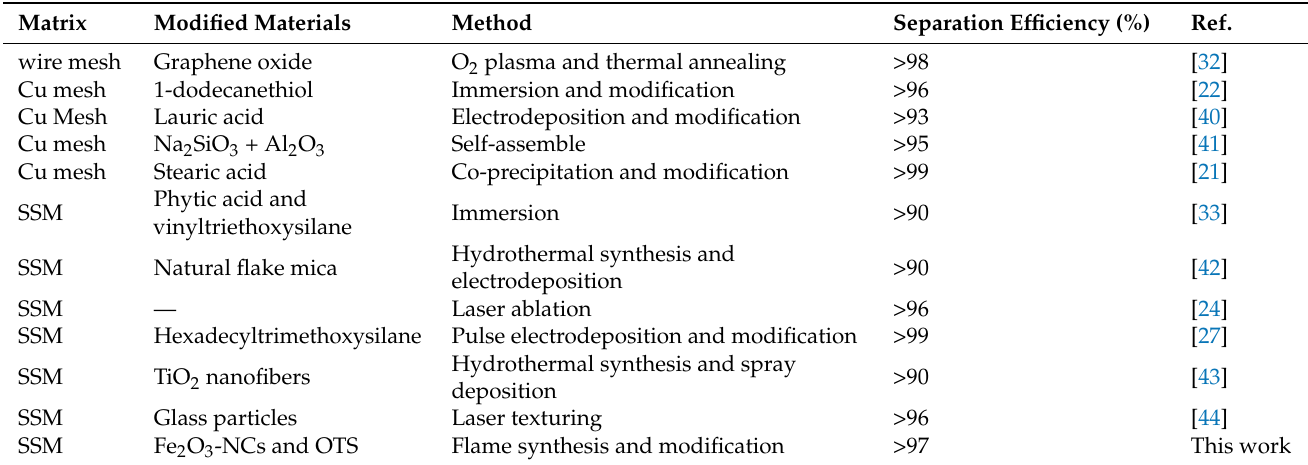
Table 1. Comparison of various meshes for oil/water